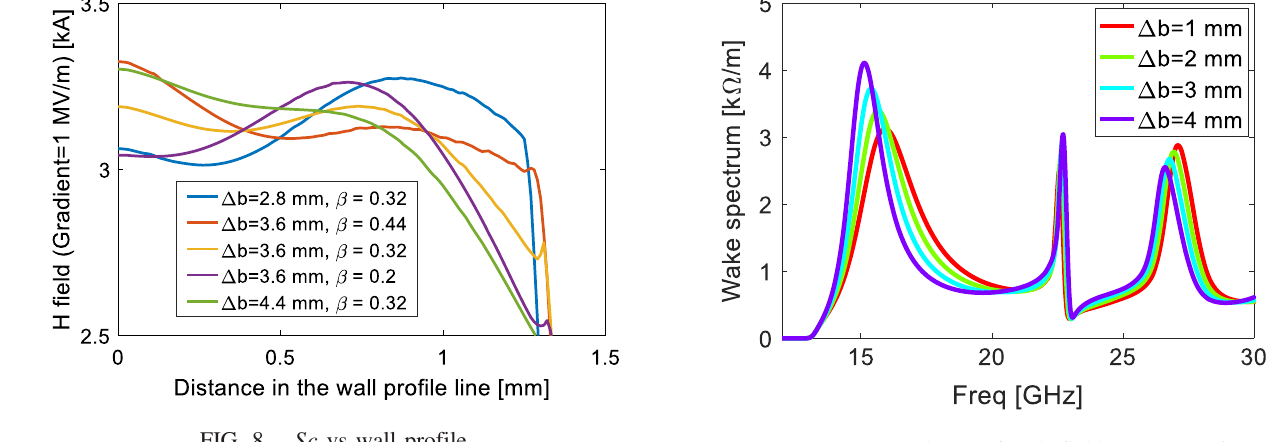
FIG. 10. Dependence of wakefield ( Wx ) on Δ b .